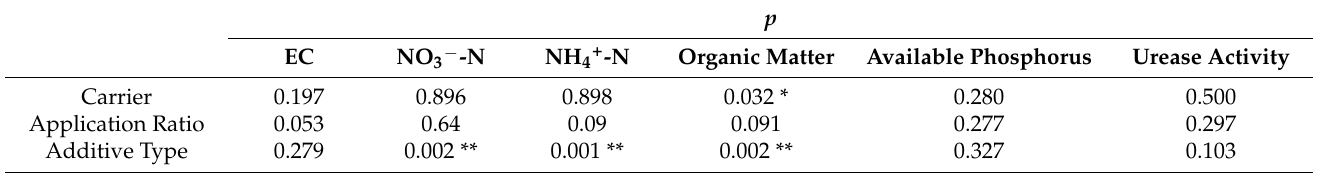
Table 5. Variance Table 5. Variance analysis.